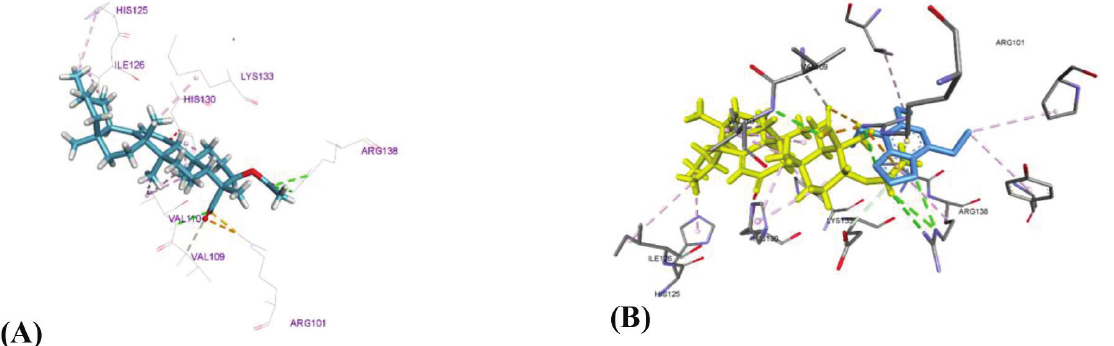
Figure 3. 3D visualization of interaction with amino acid residues of the LOX-5 active site ( A ) reference ligand of AKBA; (B) native AKBA ligand compatible conformation (yellow molecule) with apiol (blue